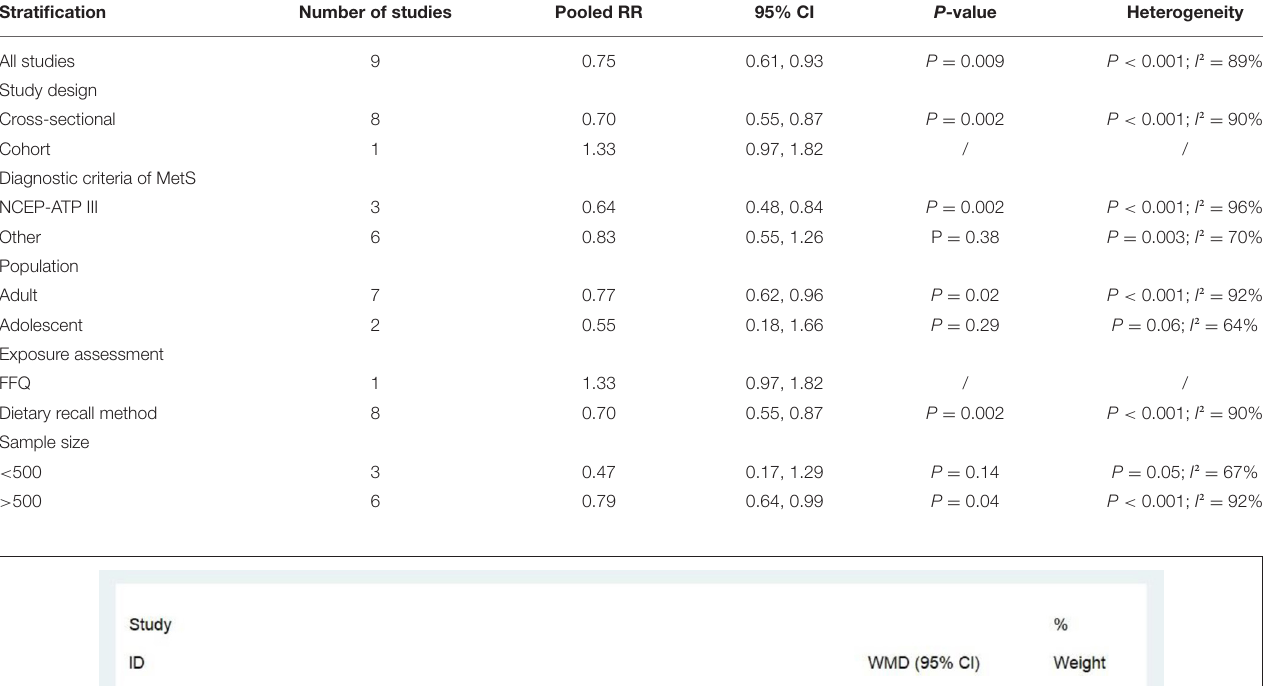
TABLE 2 | Subgroup analysis of MetS for the highest vs. lowest dietary zinc intake category. Stratification